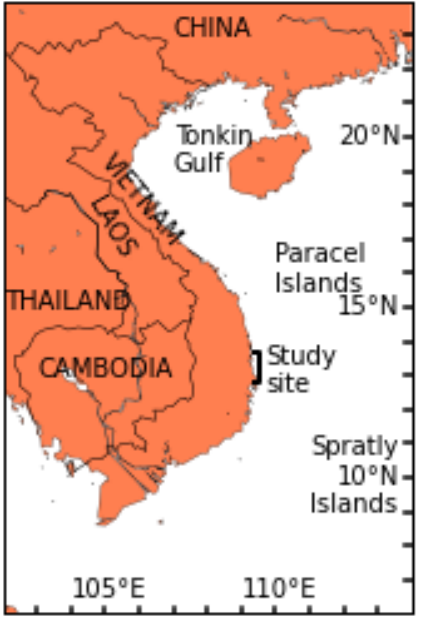
Fig. 1. Location of Phu Yen coast (the study site) in